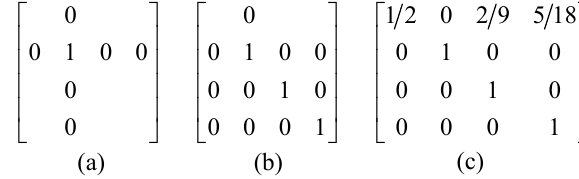
Figure 2. An example of generating the transfer matrix: ( a ) assigning the elements for the equal class; ( b ) assigning the elements for the increase class; and ( c ) assigning the elements for the decrease class.